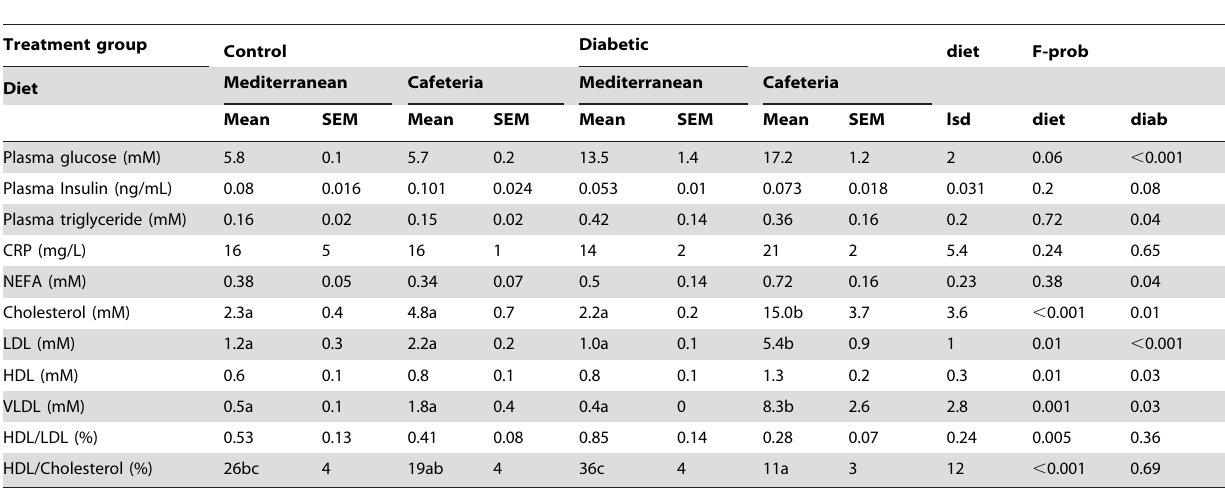
Table 2. Plasma parameters after 16 hours fasting of control and diabetic pigs fed either the Mediterranean or cafeteria diet.